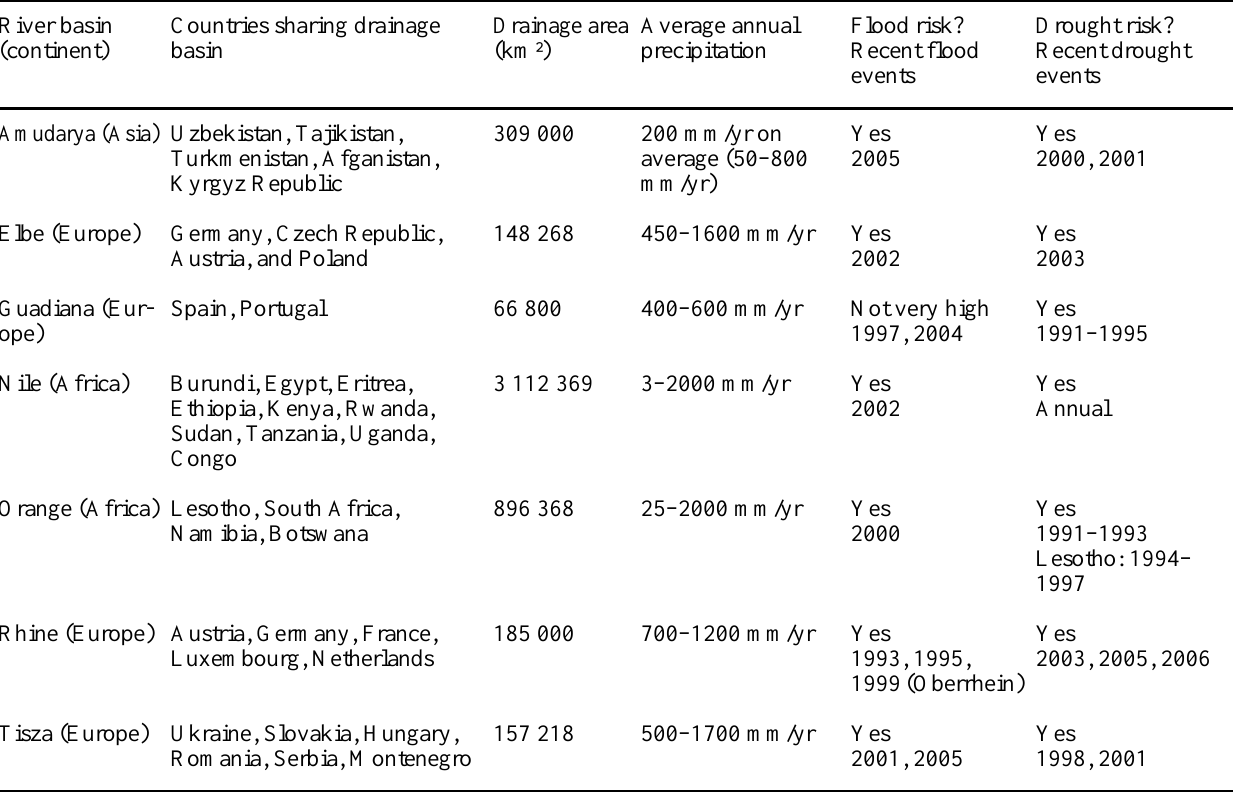
Table 4. General characteristics of the seven river basins examined in this study. River basin